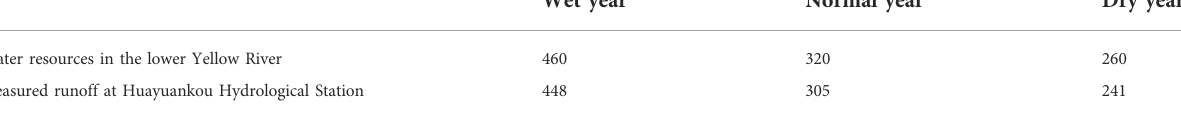
TABLE 2 Water resources in the lower Yellow River/10 8 m 3 .